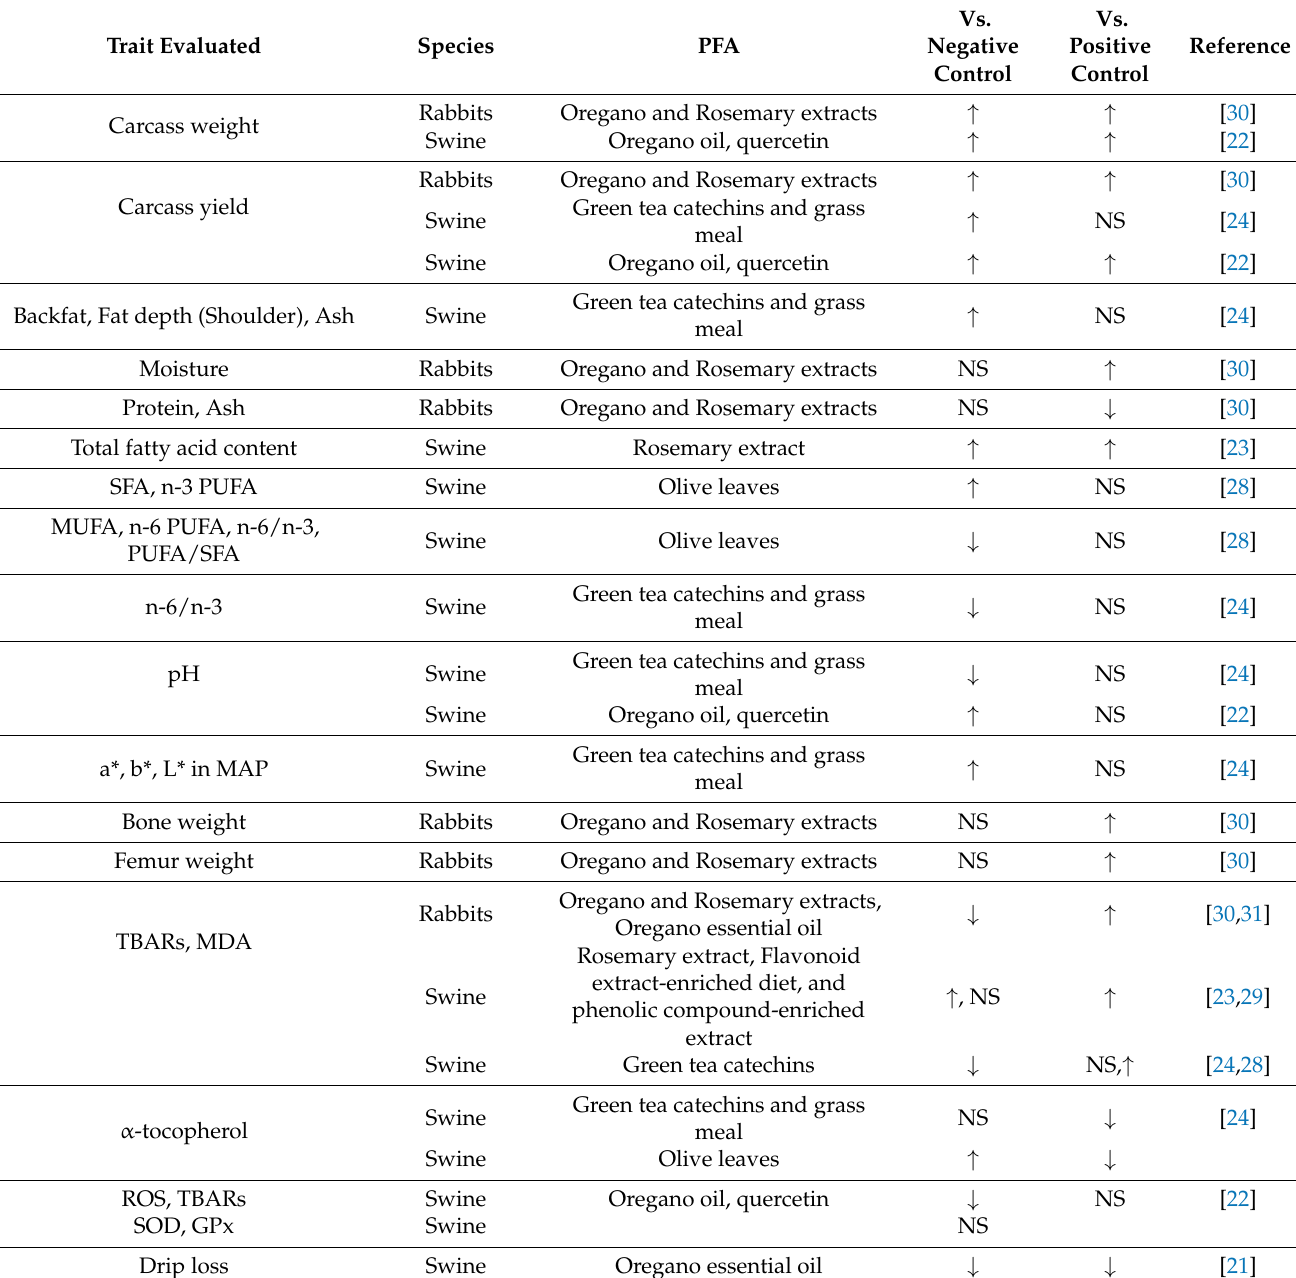
Table 1. Effects of plant feed additives on monogastric meat quality